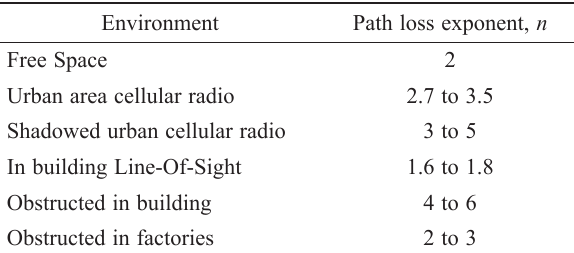
Table 1. Path loss exponent, n , according to different environments (Rappaport 2002)